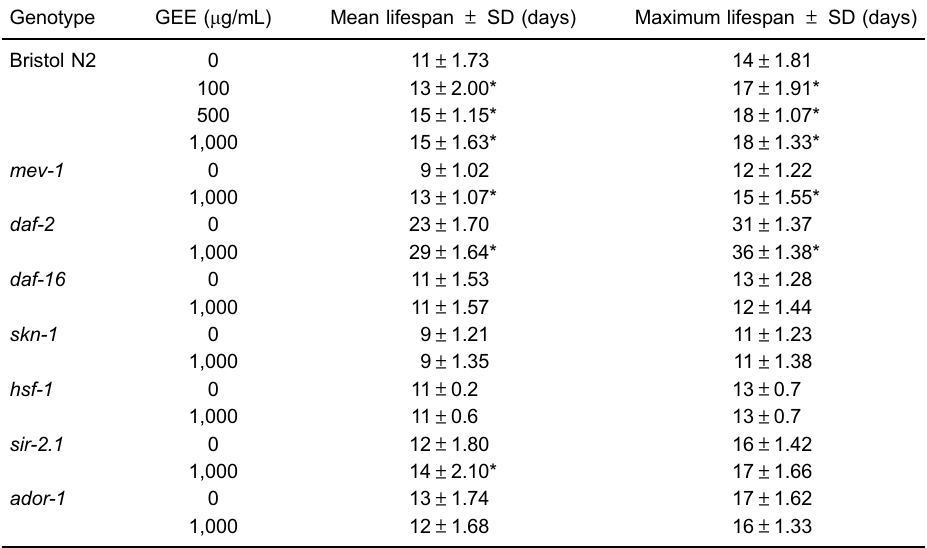
Table 1. Lifespan of untreated and guarana ethanolic extract (GEE)-treated C. elegans